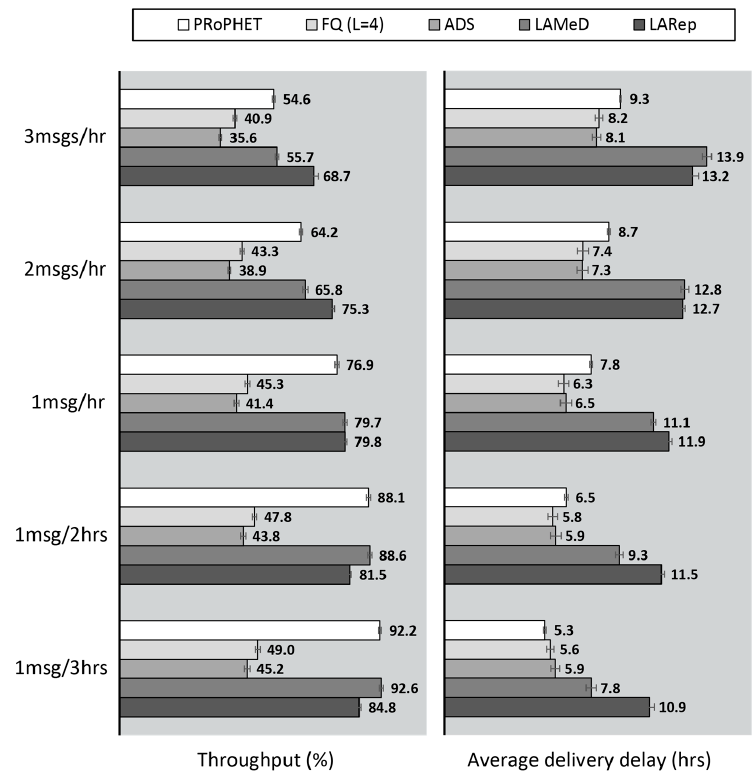
Figure 21. Throughput and average delivery delay under increasing data traffic in the Helsinki